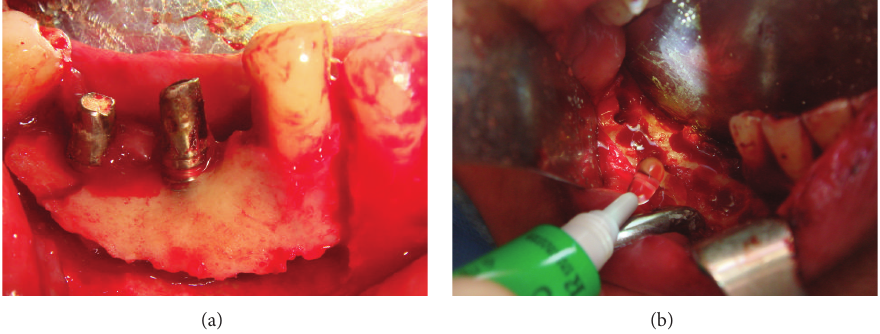
Figure 5: Alveolar bone marginal resection and intraoperative intracavitary application of Aminogam